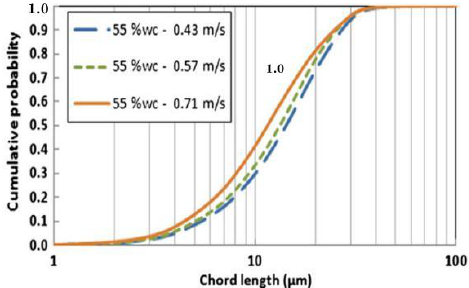
Figure 7. Results for the emulsions based on crude oil for velocities ranging from 0.43 to 0.71 m/s at 55% water cut; The wc represents water cut [65].